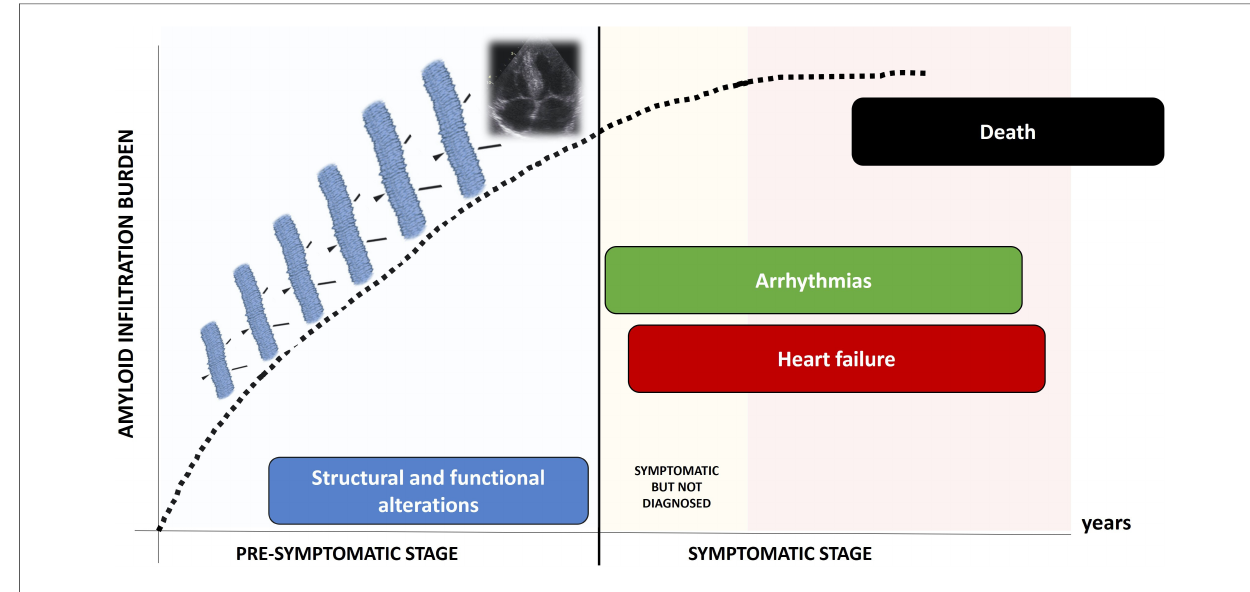
FIGURE 1 Natural history of TTR-CA: the pre-symptomatic stage and the symptomatic